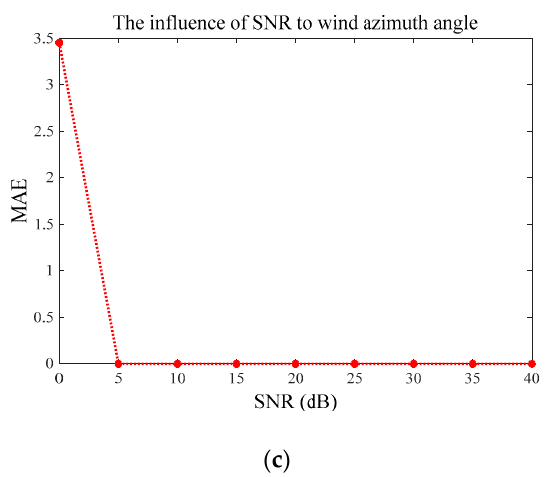
Figure 6. Results of mean absolute error (MAE) under different SNRs: ( a ) MAE of the wind speed, ( b ) MAE of the wind pitch angle, and ( c ) MAE of the wind azimuth angle.